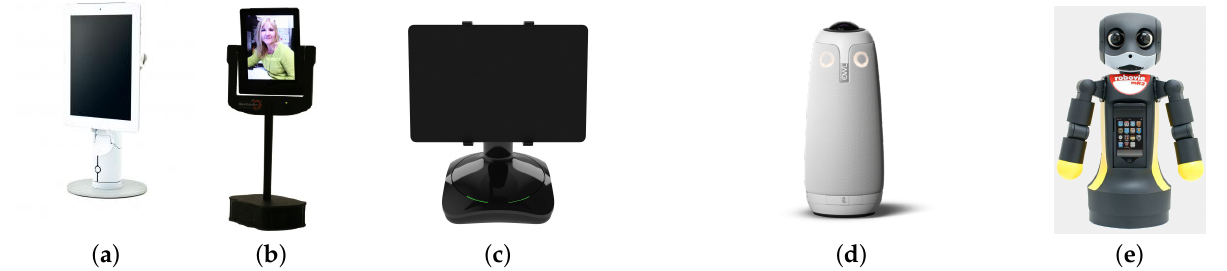
Figure 4. Unmovable robotic telepresence (RP) systems: ( a ) Kubi, ( b ) TableTop TeleMe, ( c ) SelfieBot, ( d ) Meeting Owl Pro, and ( e ) Robovie